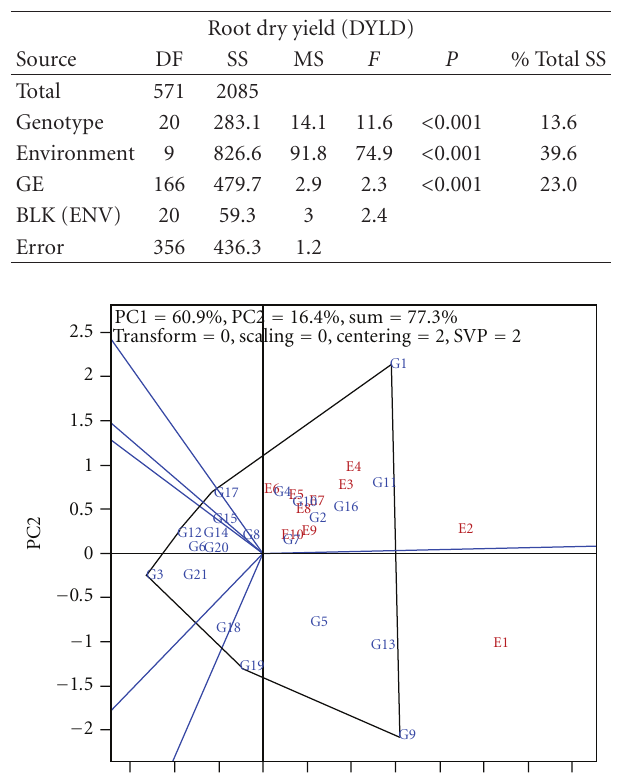
Table 5: Combined analysis of variance table of genotype, envi- ronment, and genotype by environment contributions to the sum of squares of root dry yield of 21 yellow-fleshed genotypes in 10 environments.